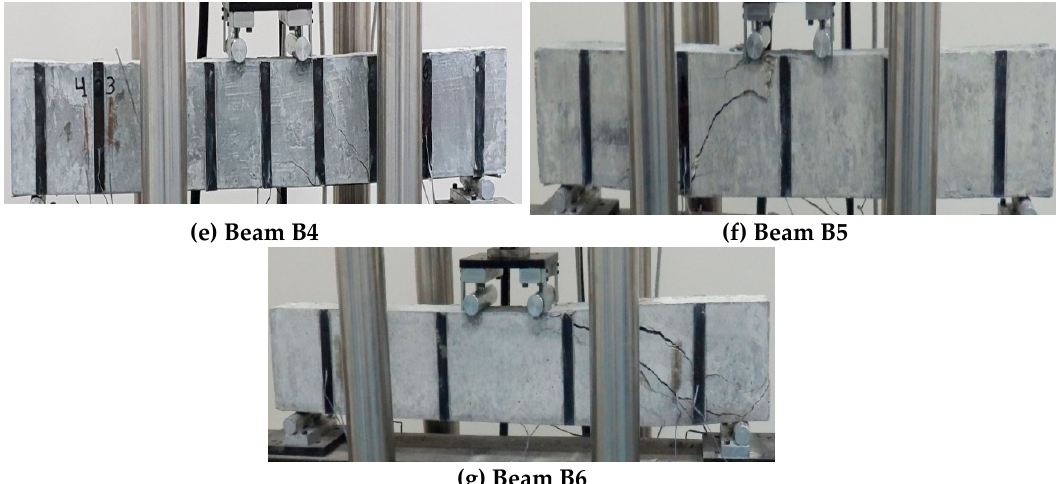
Figure 11. Failure pattern of the beams under flexural tests: ( a ) Control C1, ( b ) B1, ( c ) B2, ( d ) B3, ( e ) B4, ( f ) B5 and ( g ) B6.